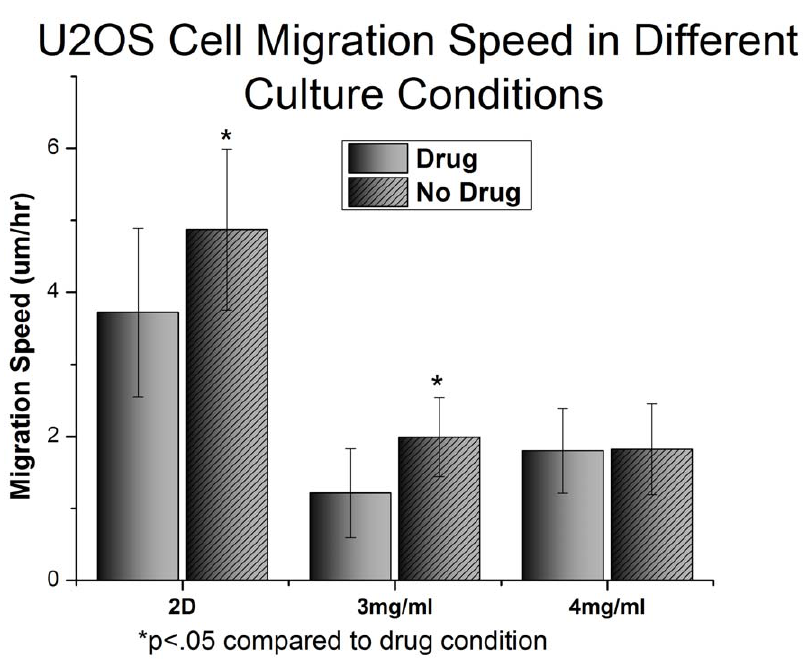
Figure 10. Migration of U2OS cells over 6 hours in different culture conditions. Cells were stained with CMRA whole cell stain prior to being embedded in collagen. Cells were tracked by imaging the gels every 15 minutes for 6 hours. Cell speed was calculated using a 3D displacement algorithm performed on cell centroid location data from Imaris H .